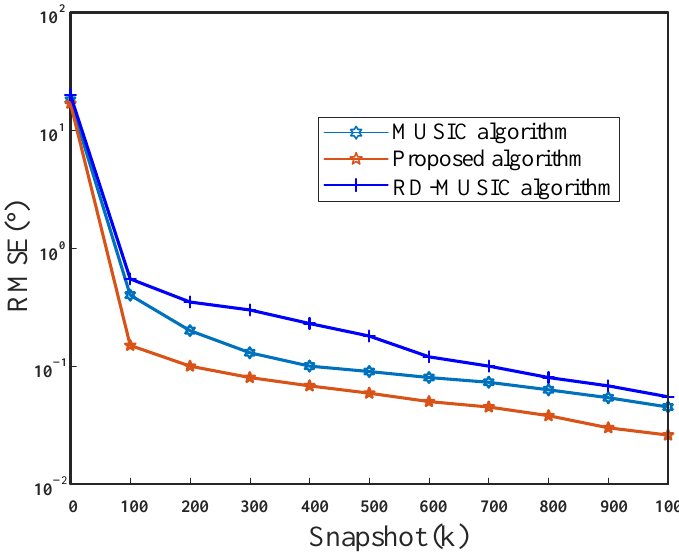
Figure 11. RMSE versus the snapshot for phi.